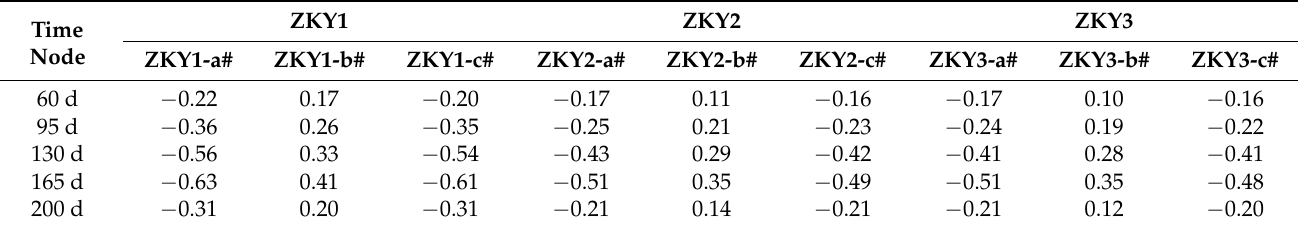
Table 1. Monitoring values of frost heaving force at different time nodes (unit: MPa).